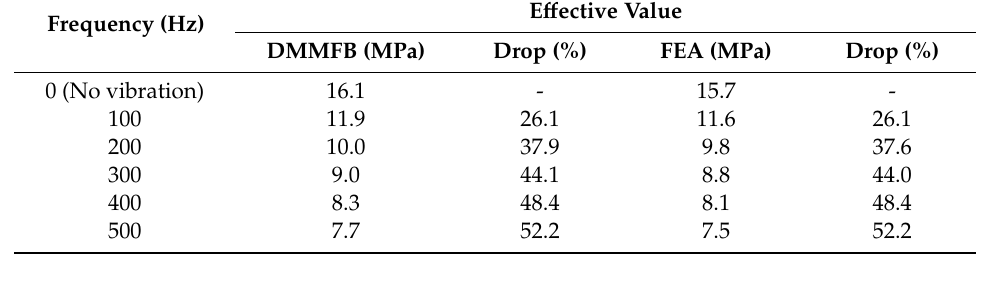
Table 4. E ff ective value of the pressure drop without and with 0.3 g vibration applied at di ff erent frequencies.